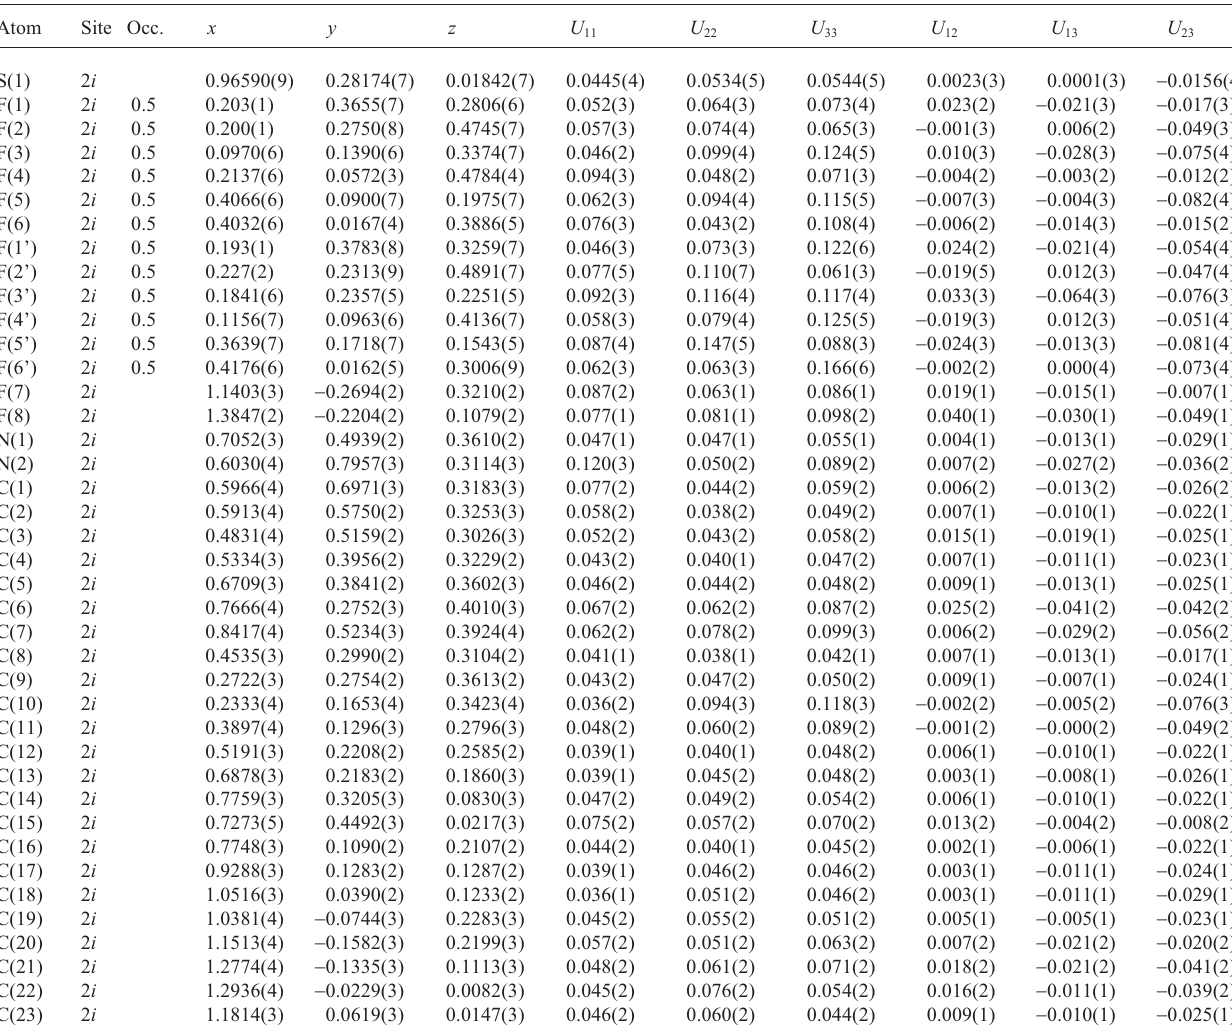
Table 3. Atomic coordinates and displacement parameters (in Å 2 )